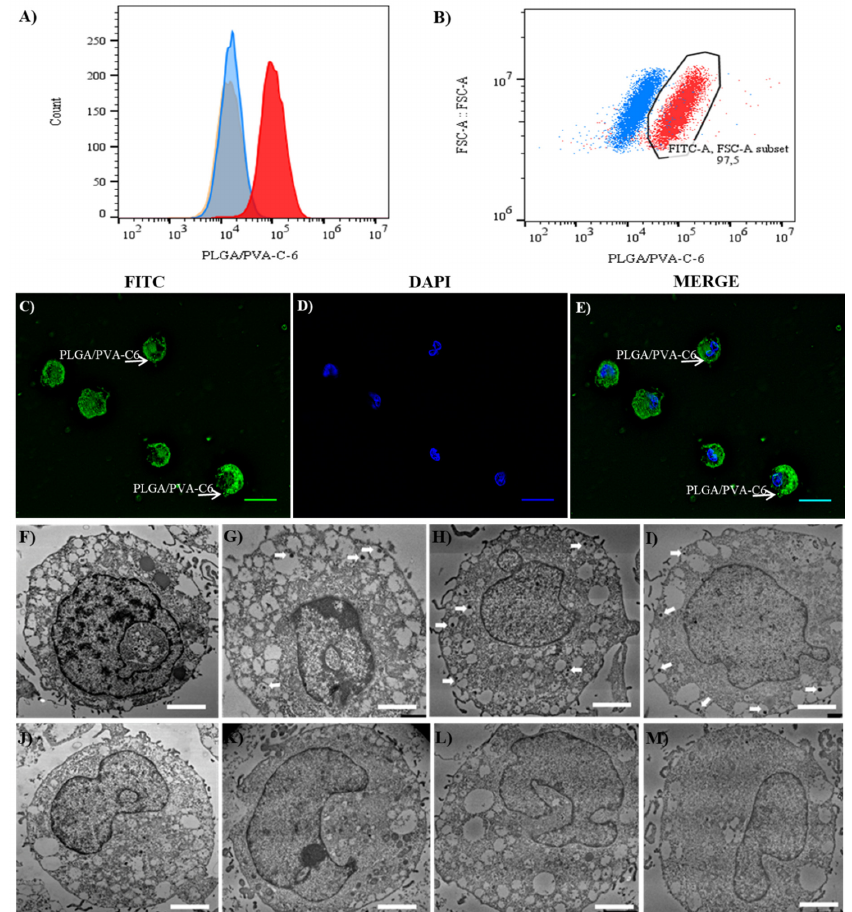
Figure 3. PLGA/PVA nanoparticle internalization. Panel ( A ) shows the cell internalization of PLGA/PVA-C6, determined by flow cytometry analysis, histograms in panel ( A ) show a shift in fluorescence intensity of LAD2 cells exposed to PLGA/PVA-C6 for 24 h (red histogram), compared to untreated control cells (orange histogram) and PLGA/PVA (blue histogram) controls. Percentages of fluorescently labelled LAD2 cell-gated population in comparison to PLGA/PVA treated cells are also shown in panel ( B ). Cell internalization of green fluorescent coumarin-6-loaded NPs visualized using an FITC filter by fluorescence microscopy, showing cell internalization by LAD2 cells ( C ), DAPI-stained nuclei ( D ), and merge of PLGA/PVA-C6 and DAPI stains ( E ), scale bar 10 µm. TEM micrographs of intracellular structure of LAD2 cells exposed to PLGA/PVA-21 ( H , L ), PLGA/PVA-22 ( I , M ), and PLGA/PVA ( G , K ). Untreated cells ( F , J ) were included as controls. LAD2 cells were exposed to PLGA/PVA SQ nanoparticles for 3 h ( F – I ), and 24 h ( J – M ). Scale bars are 2 µm, arrowheads show internalized PLGA/PVA nanoparticles.